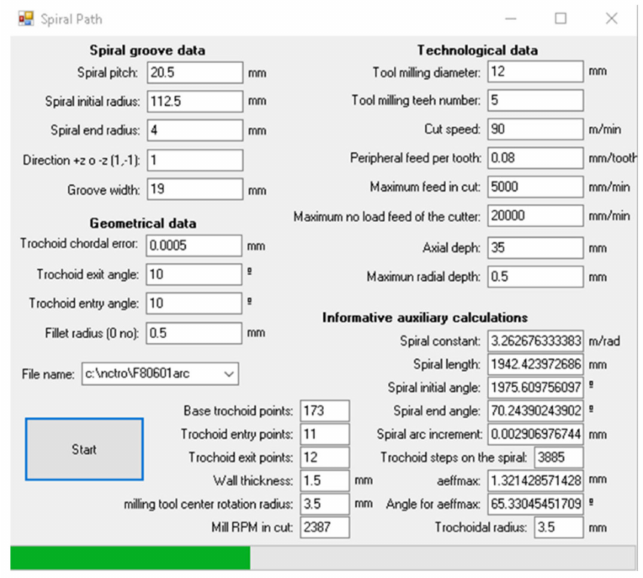
Figure 19. Visual Net data form.